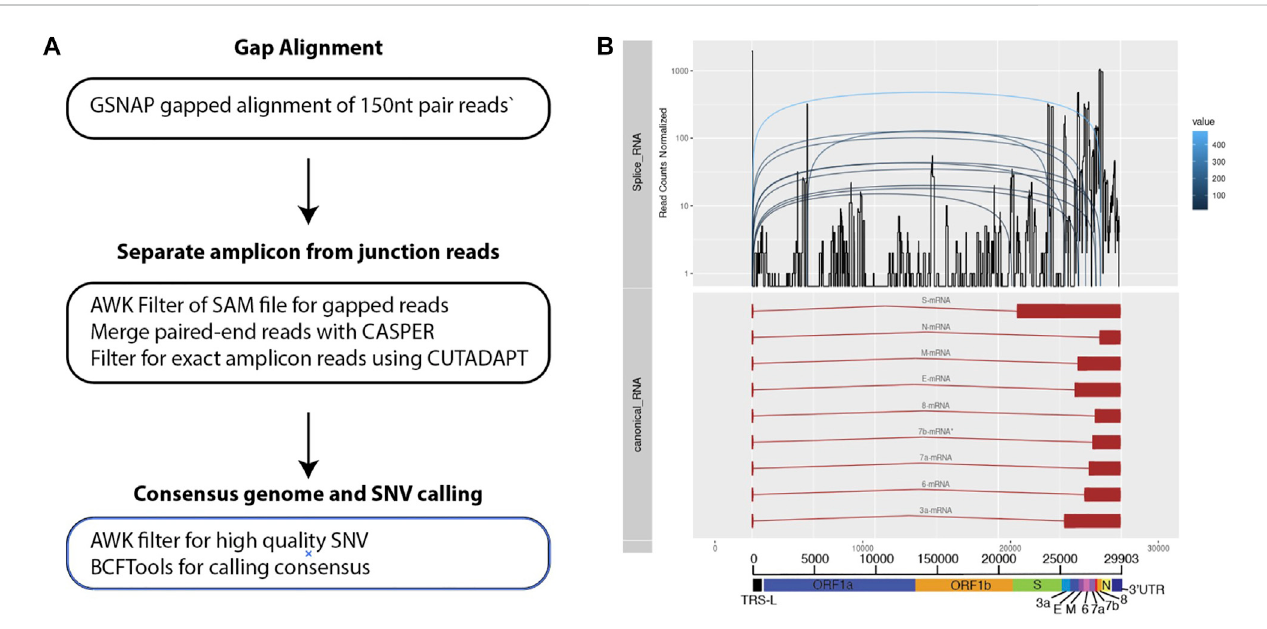
FIGURE 1 Bioinformatics work fl ow for identi fi cation and visualization of gappedreads and amplicons. (A) Threemain stages of processing the sequenced data. (B) Multiple track visualization of the sequenced data. X-axis corresponds to the COVID genomic length. The top track of the fi gure re fl ects the structure of the known and annotated sequences of subgenomic transcripts. The second tracks show an example of the coverage of junctions reads identi fi ed using the pipeline speci fi ed. Distinct peaks are observed that corresponds to the canonical transcripts on the top track. The third tracks re fl ect how gapped reads are separated across the subgenomic